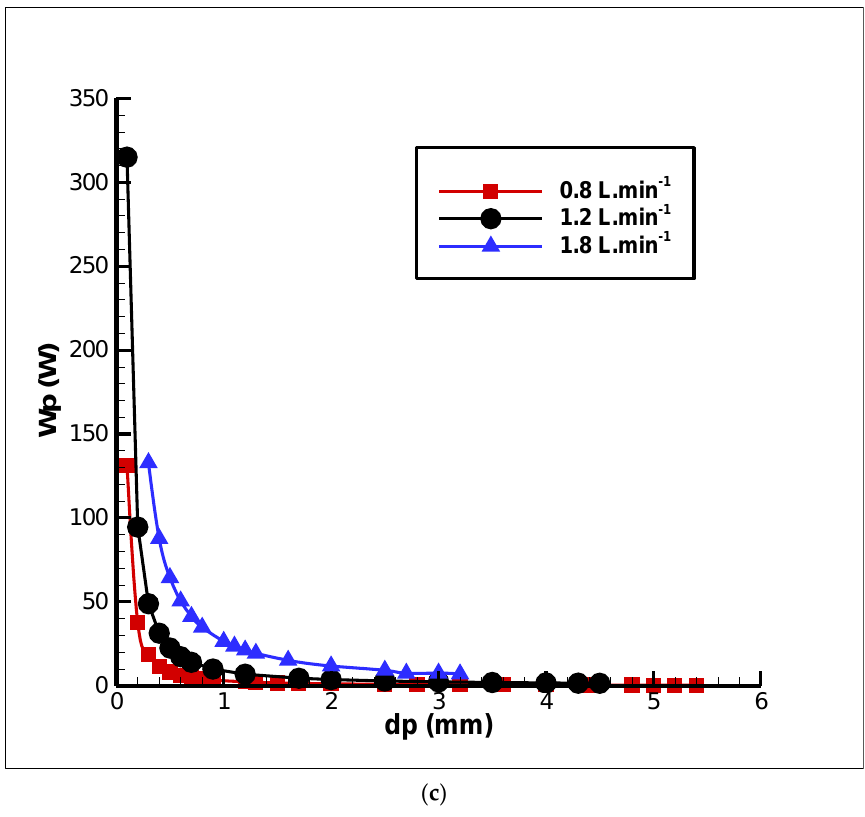
Figure 13. The power pump based on the of the sphere particle diameter at a different volumetric flow rate in the temperature span of 1 K: ( a ) frequency of 4 Hz, ( b ) frequency of 2 Hz, and ( c ) frequency of 1 Hz.